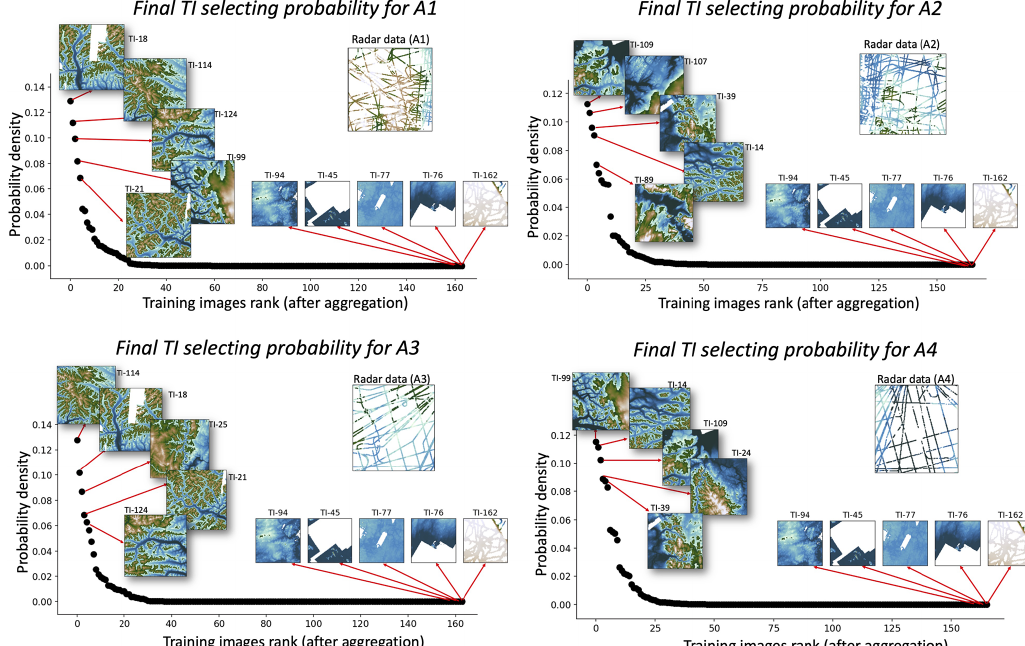
Figure 10. Probability distribution of final aggregated TI probability in each radar line subarea.